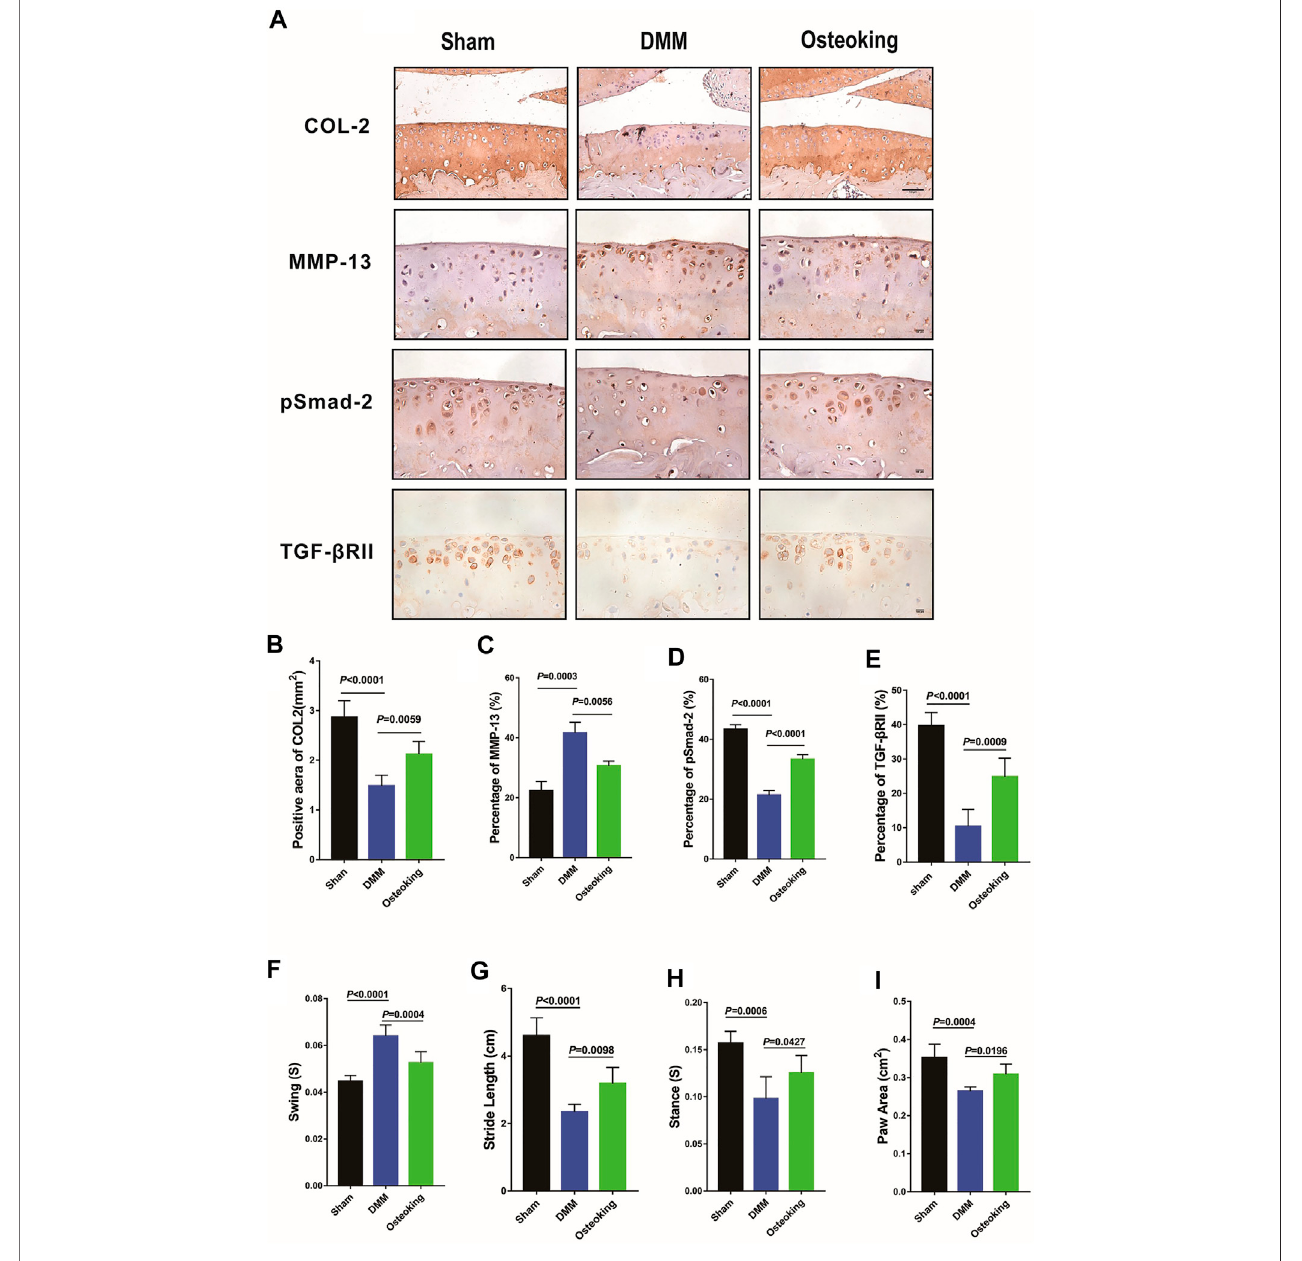
FIGURE3| Osteokingup-regulatedtheexpressionofTGF β RIIandpSmad2inDMM-inducedWTosteoarthriticmice. (A) immunohistochemicalstainingofCol2,MMP- 13, and pSmad2 and TGF β RII in cartilage. Scale bar (cid:2) 100 μ m. (B – E) Quanti fi cation of the positive repression area of Col2 (mm 2 ), Percentage of positive expression of pSmad2, TGF β RII, and MMP-13 (%). Gait analysiswas performed by DigiGait imaging system. (F) Swing (s), (G) Stride length (cm), (H) Stance (s), (I) Paw area (cm 2 ) ofthe right hind limb were chosen as the observation index. The Data are presented as means ± SD (n (cid:2) 10). The exact p value is presented in the corresponding graph.